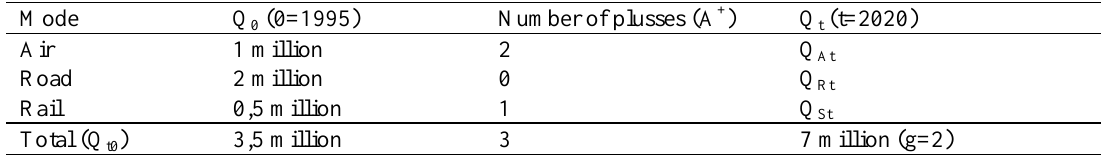
Table 12. Example of the calculation